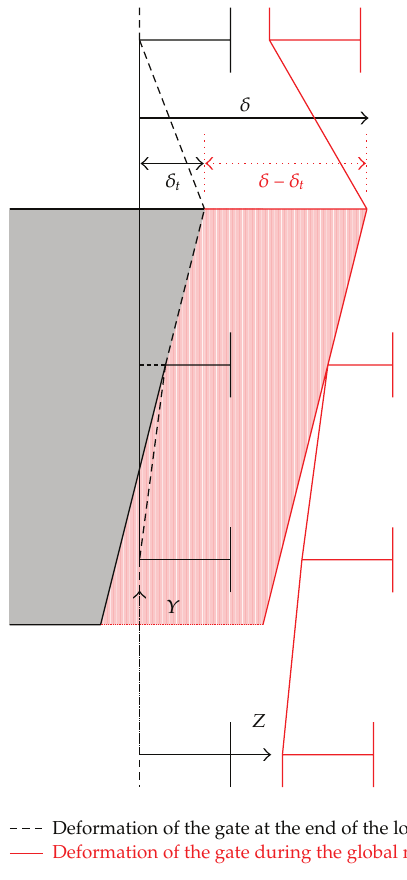
Figure 27: Total displacement δ and global displacement δ − δ t